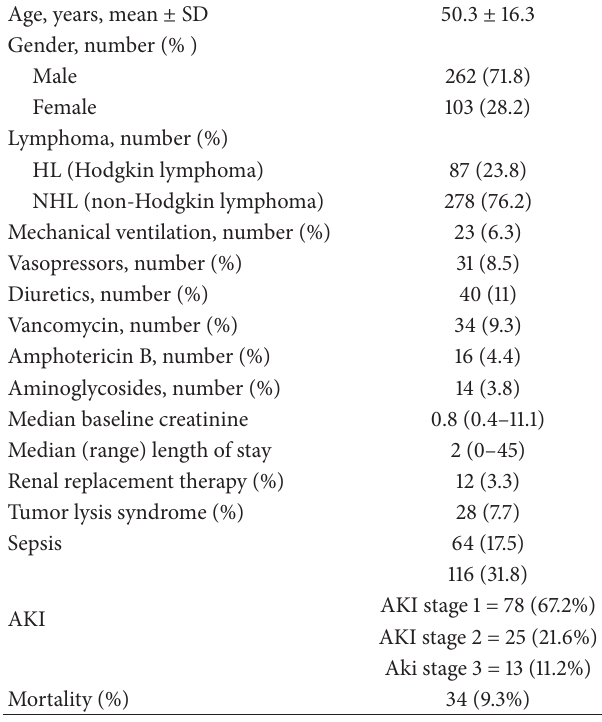
Table1:Demographiccharacteristicsofstudypopulation( 𝑛 = 365